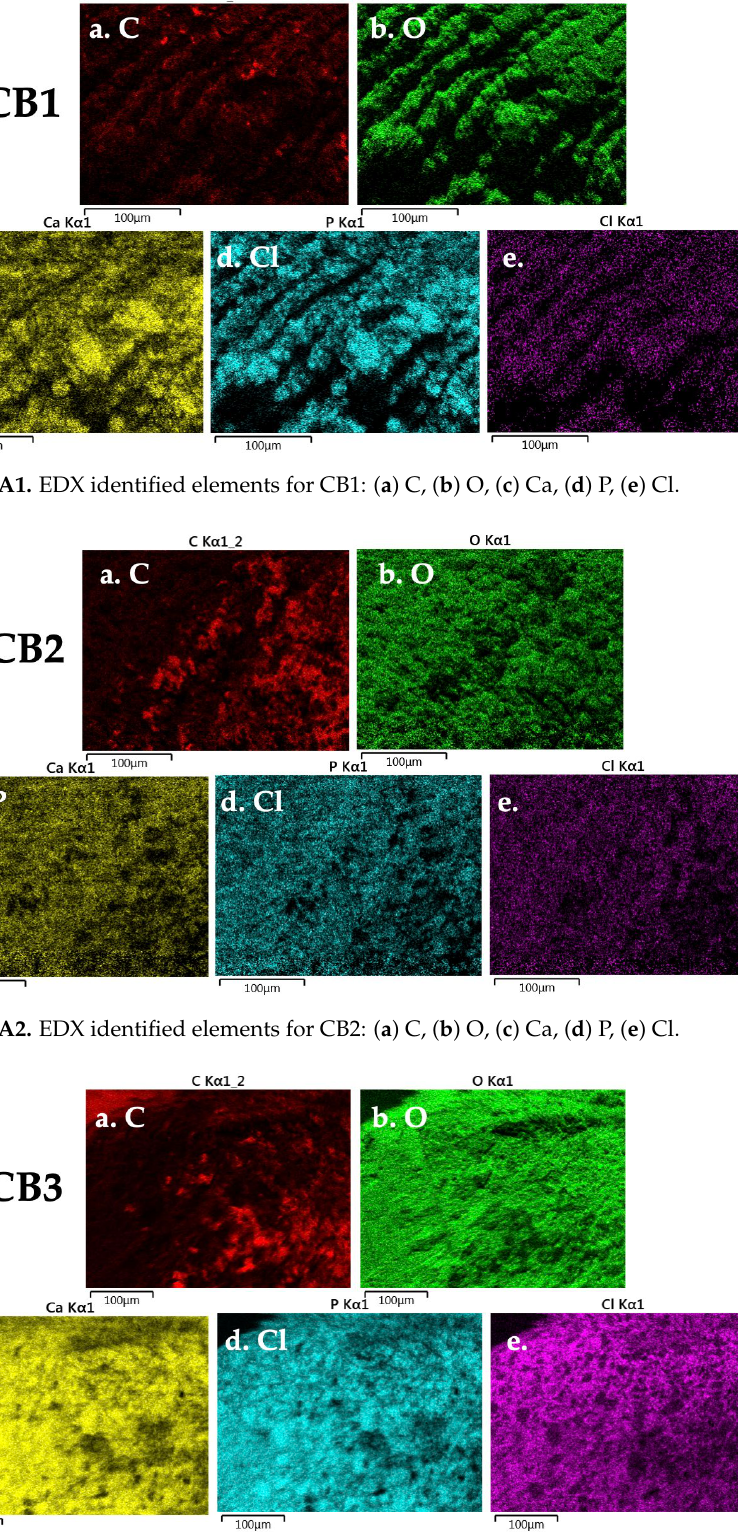
Figure A3. EDX identified elements for CB3: ( a ) C, ( b ) O, ( c ) Ca, ( d ) P, ( e ) Cl .